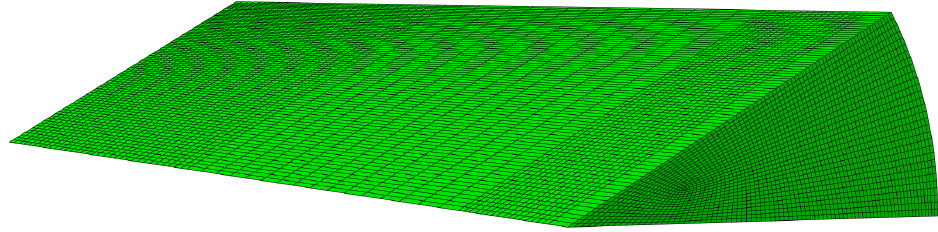
Figure 13. Mesh used to reproduce the experimental